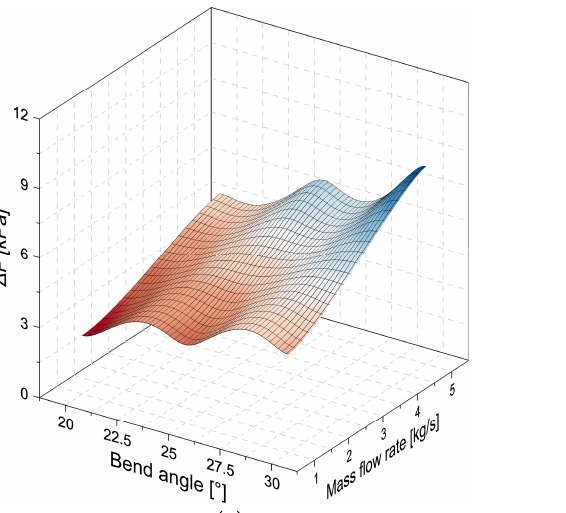
Figure 12. Bend angle for: ( a ) conventional zig-zag channel; ( b ) modified zig-zag channel.